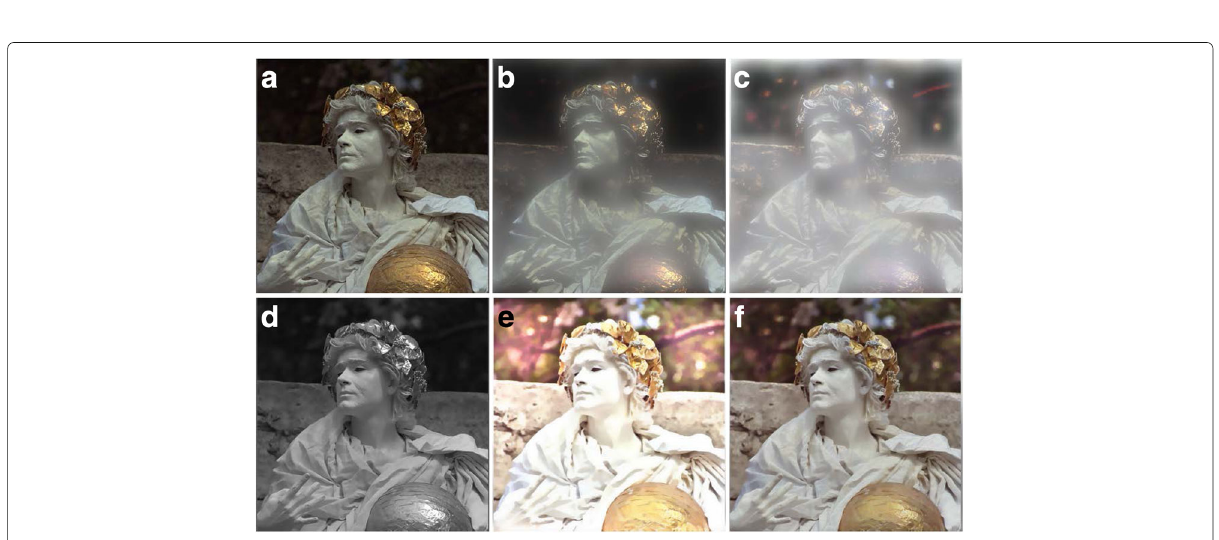
Fig. 2 Resulting images of each algorithm step: a input image; b estimated illumination image; c adjusted illumination image of b ; d bright channel of a ; e estimated reflectance image; and f resulting image using c , e ( λ 1 = 300, λ 2 = 0.1, λ 3 = 0.9, and ω =